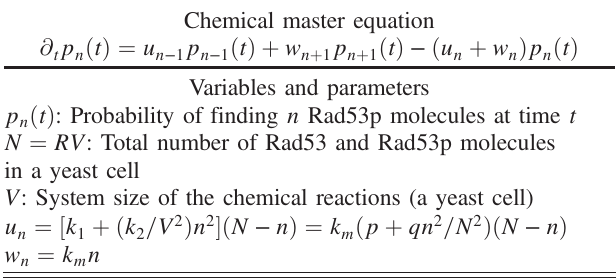
TABLE II. Stochastic model of Rad53 phosphorylation. Chemical master equation